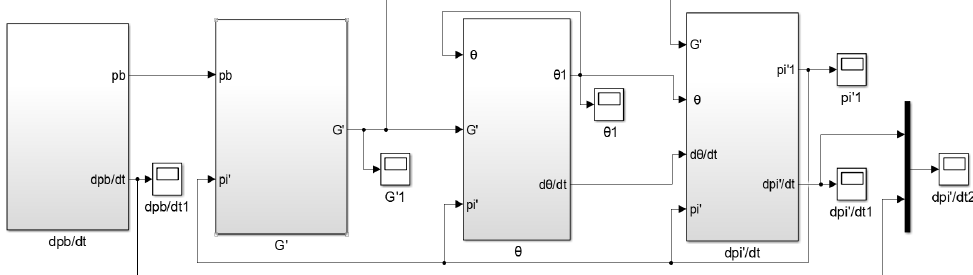
Based on the simulation model of the brake chamber with the inflation process, com- bined with Equations (29)–(31) and (34), the simulation model of the brake pressure change rate considering temperature change is established, as shown in Figure 13.